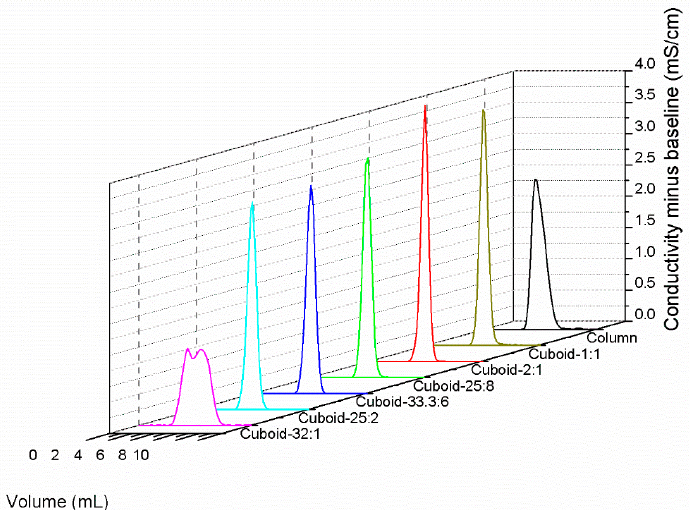
Figure 3. Salt peaks obtained with the six cuboid packed-bed devices and their equivalent column at low flow rate (media: Capto Q anion exchange, bed volume: 5 mL, mobile phase: 0.4 M NaCl, tracer: 0.8 M NaCl, loop: 0.1 mL, conductivity baseline was normalized for comparison, flow rate: 0.5 mL/min, v S = 15 cm/h). Processes 2018 , 6 , x FOR PEER REVIEW